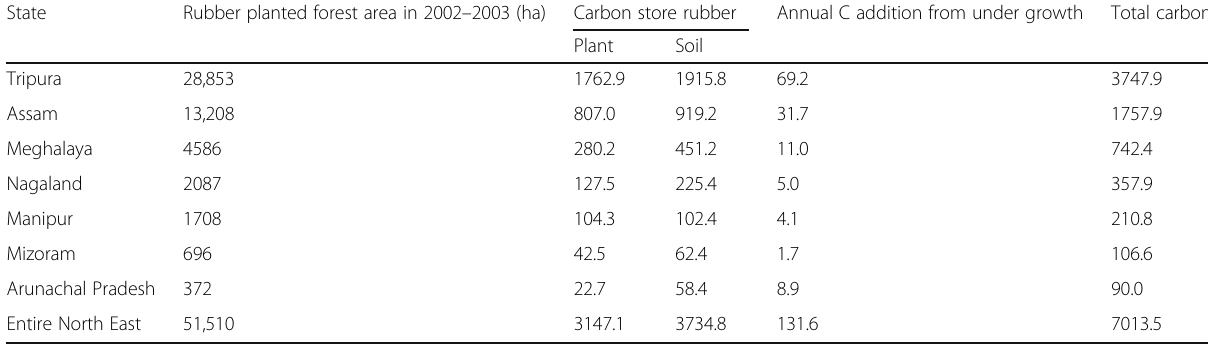
Table 4 Carbon sequestration (t ha − 1 ) by planted forest of rubber in North Eastern India